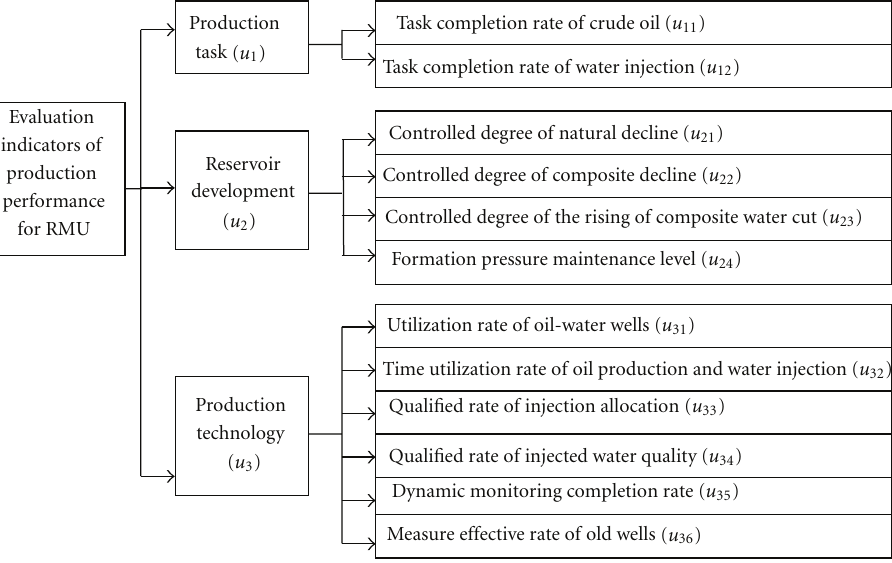
Figure 1: Hierarchical relationship of the evaluation